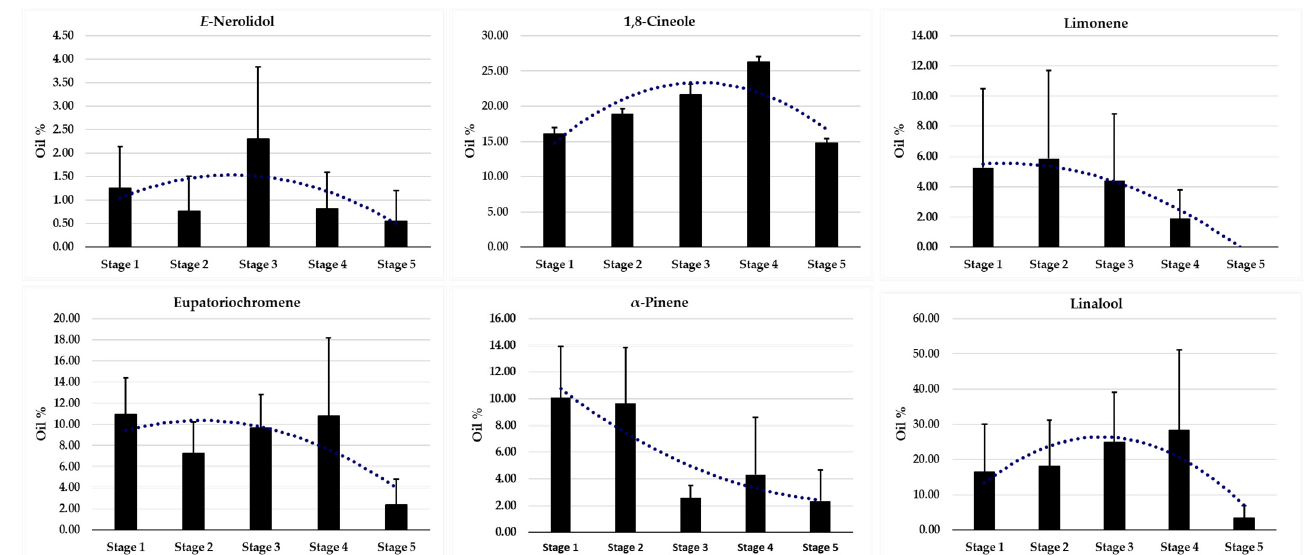
Figure 1. Percentage content (mean standard deviation) of the major compounds vs. stages of development of the reproductive organ of Piper mollicomum Kunth, in the months of September 2020 to January 2021. For the construction of this graphics, we selected only the constituents that registered percentage contents above 5% at least once in the EOs in the periods and stages of the analyzed reproductive organs.